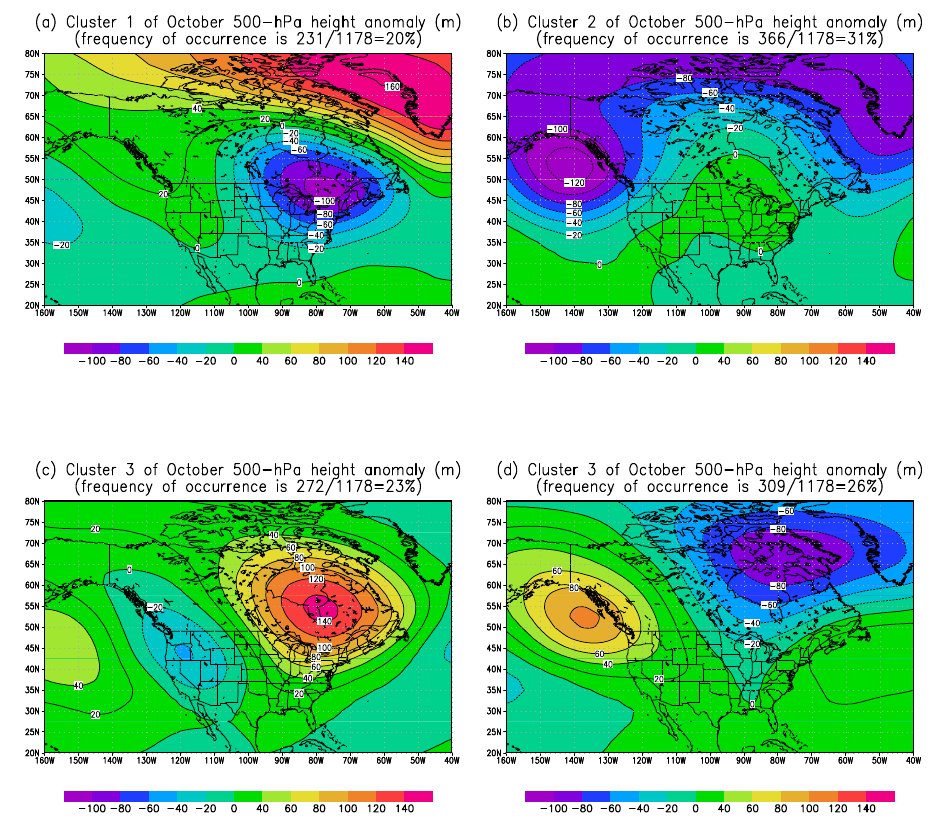
Figure 6. Four clusters of 500-mb geopotential height anomaly (m) identified based on 38-yr daily reanalysis data over all months of October, with cluster 1 in ( a ), cluster 2 in ( b ), cluster 3 in ( c ) and cluster 4 in ( d ), respectively. The frequency of occurrence of each cluster is listed inside the parenthesis of each subtitle, in terms of